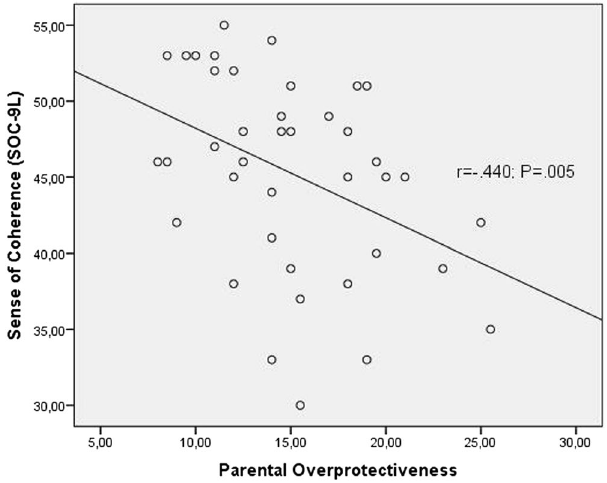
Figure 3. Spearman’s correlations between sense of coherence and parental overprotecting. The level of “parental overprotecting” was generated by using the mean-values of maternal and paternal parental overprotecting of the Recalled Parental Rearing Behavior Questionnaire (FEE). The level of sense of coherence was captured by using the Sense of Coherence Scale (SOC) in its abbreviated form of nine items